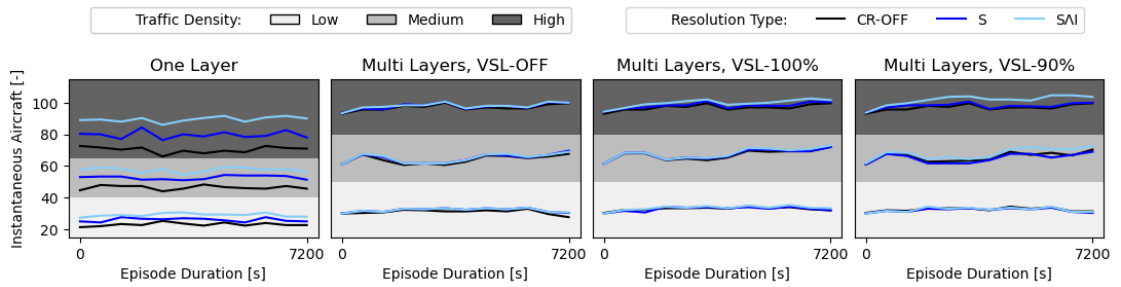
Figure 26. Mean number of instantaneous aircraft per timestep throughout the simulation